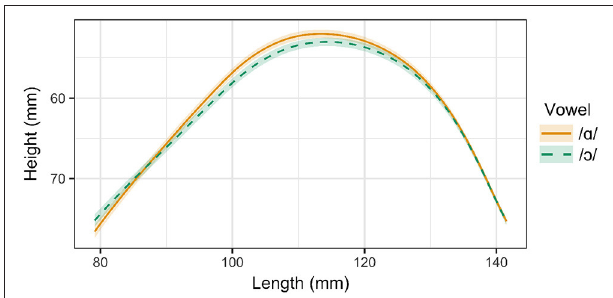
FIGURE 7 | Main effect curves for SSANOVA model of /A/ and /O/ for Speaker 6. Shading indicates 95% Bayesian confidence interval.